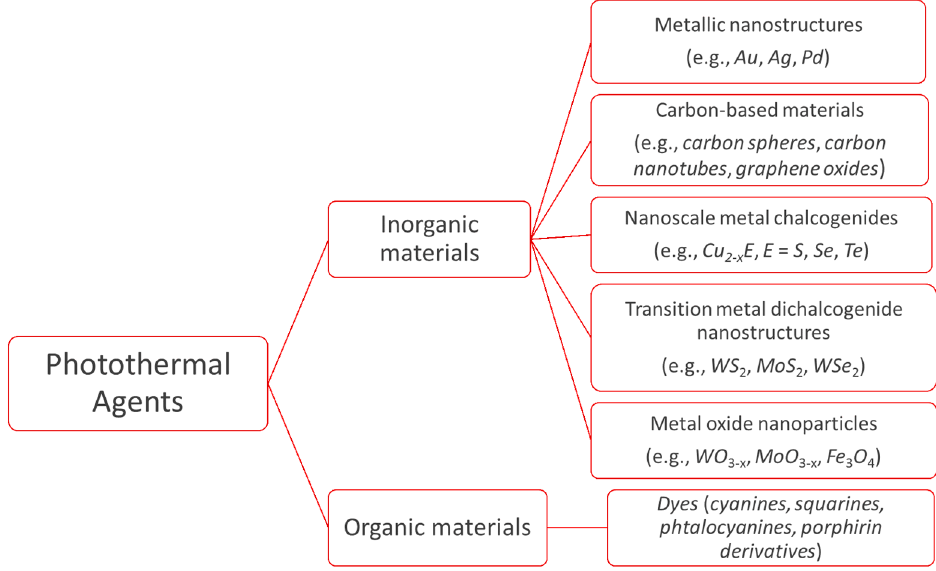
Figure 3. Classification of photothermal agents.